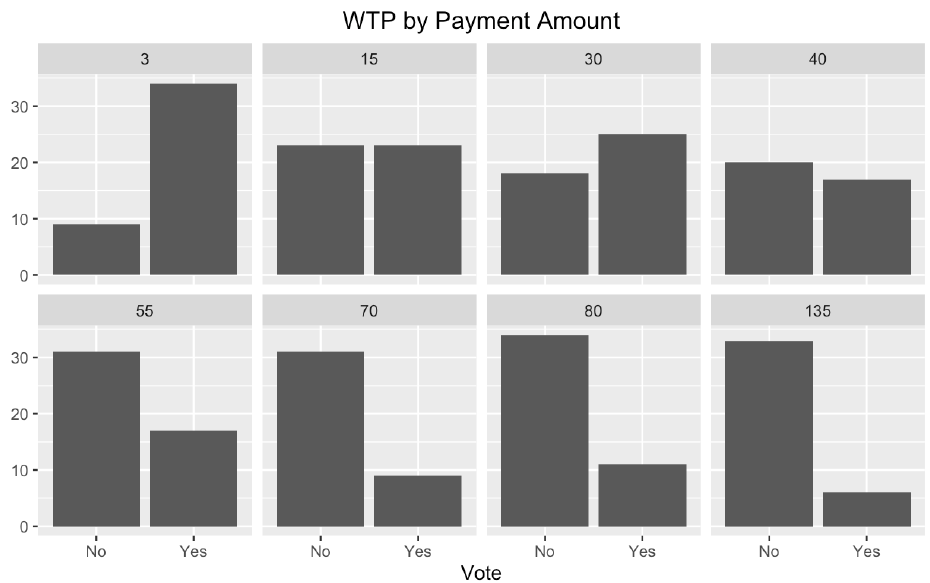
Figure 2. Number of respondents WTP by payment amount.